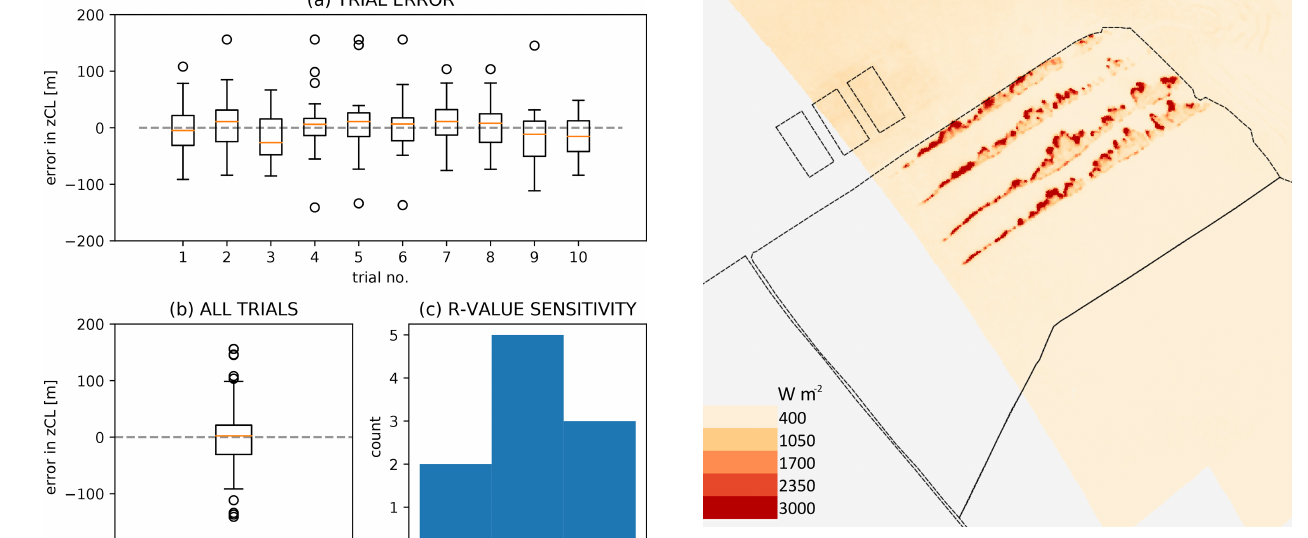
Figure 8. Long-wave infra-red (LWIR) image of L2G lot dur- ing ignition (12:32:02CST) with dashed black lines denoting burn